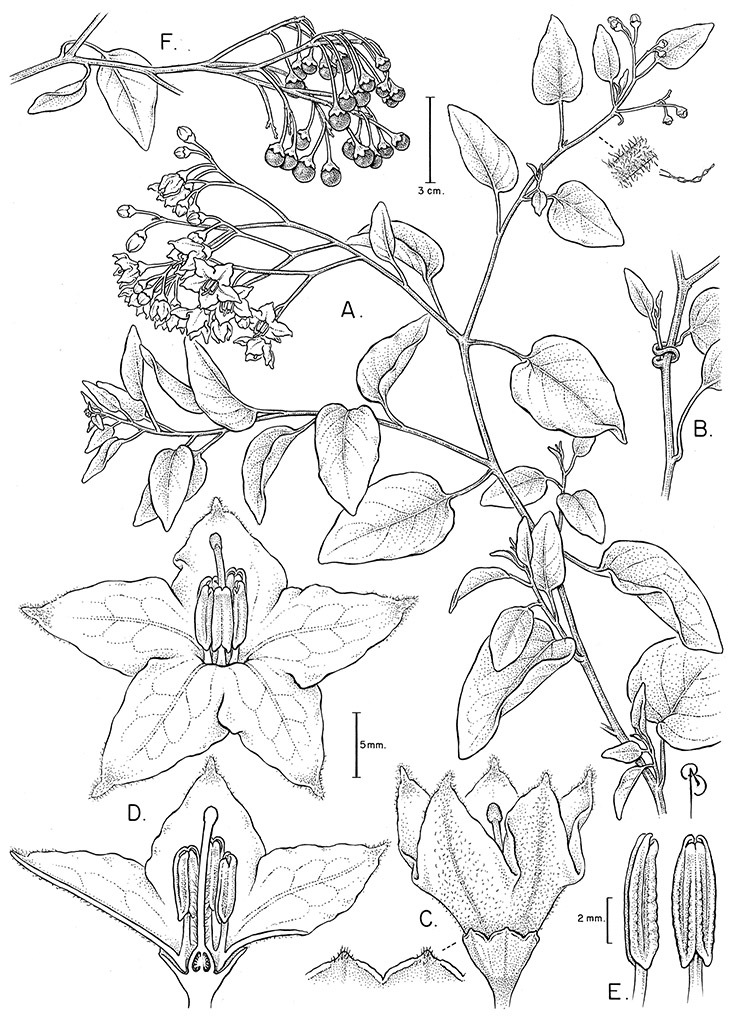
Solanum flaccidum Vell. (A–D drawn from Nee & Bohs 50809
E drawn from Nee & Bohs 50768). Illustration by Bobbi Angell.